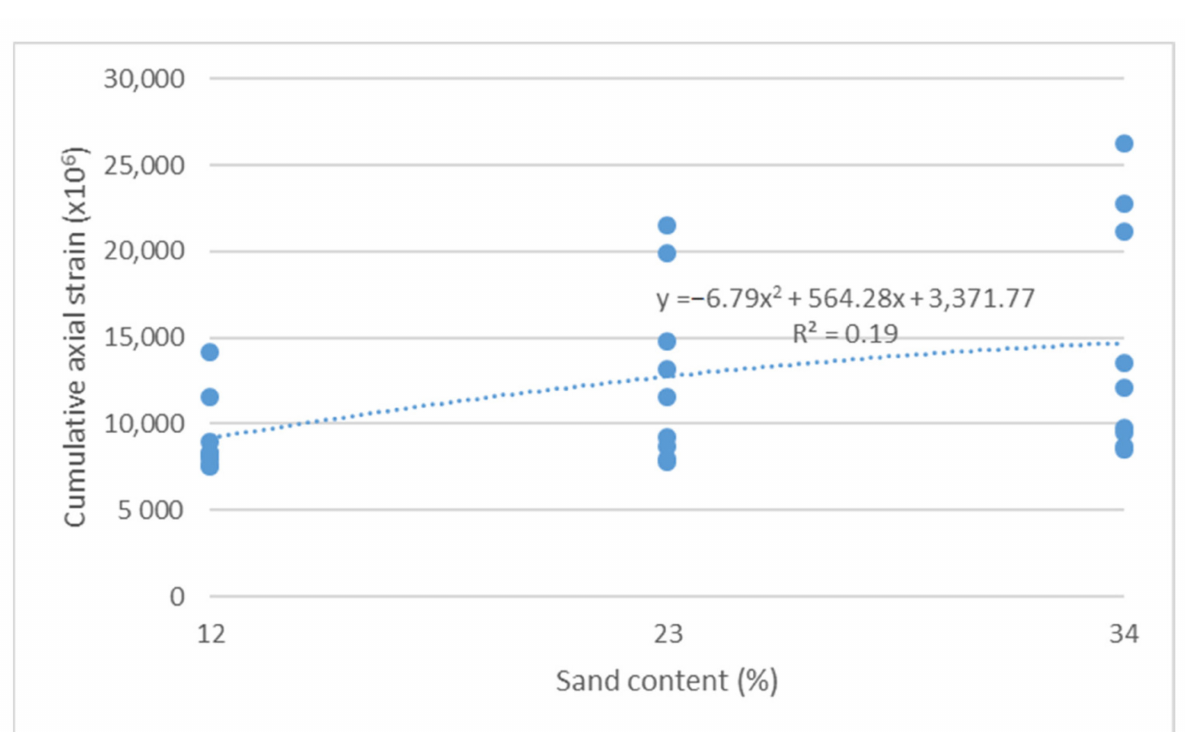
Figure 5. Cumulative axial strain vs. sand